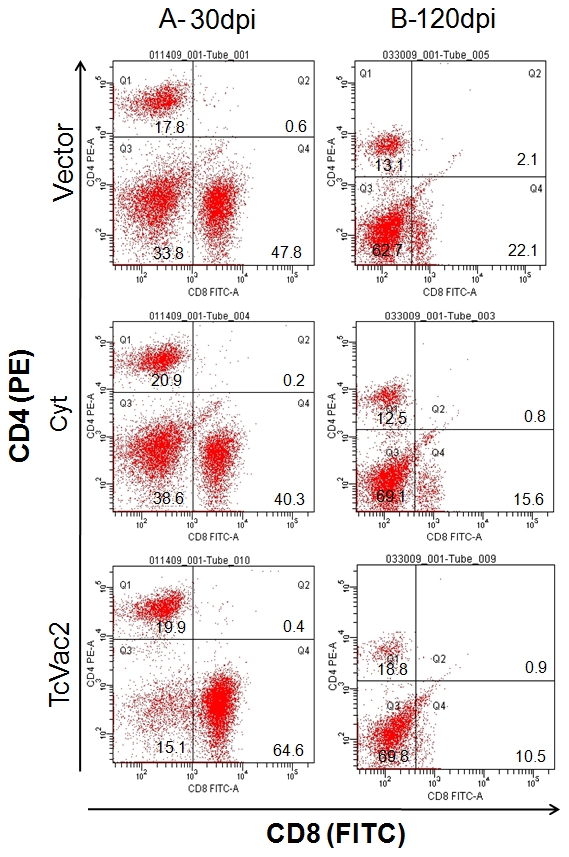
CD8+ T cell subset dominated in splenic T cell population of TcVac2-vaccinated/acutely-infected mice.Mice were vaccinated and challenged with T. cruzi, and harvested at day 30 (A) and 120 (B) post-infection, corresponding to acute infection phase and chronic disease phase, respectively. Spleen cells were incubated for 30 min with FITC-conjugated anti-CD8 and PE-conjugated anti-CD4 antibodies and CD4+ and CD8+ T cell subsets monitored by flow cytometry.